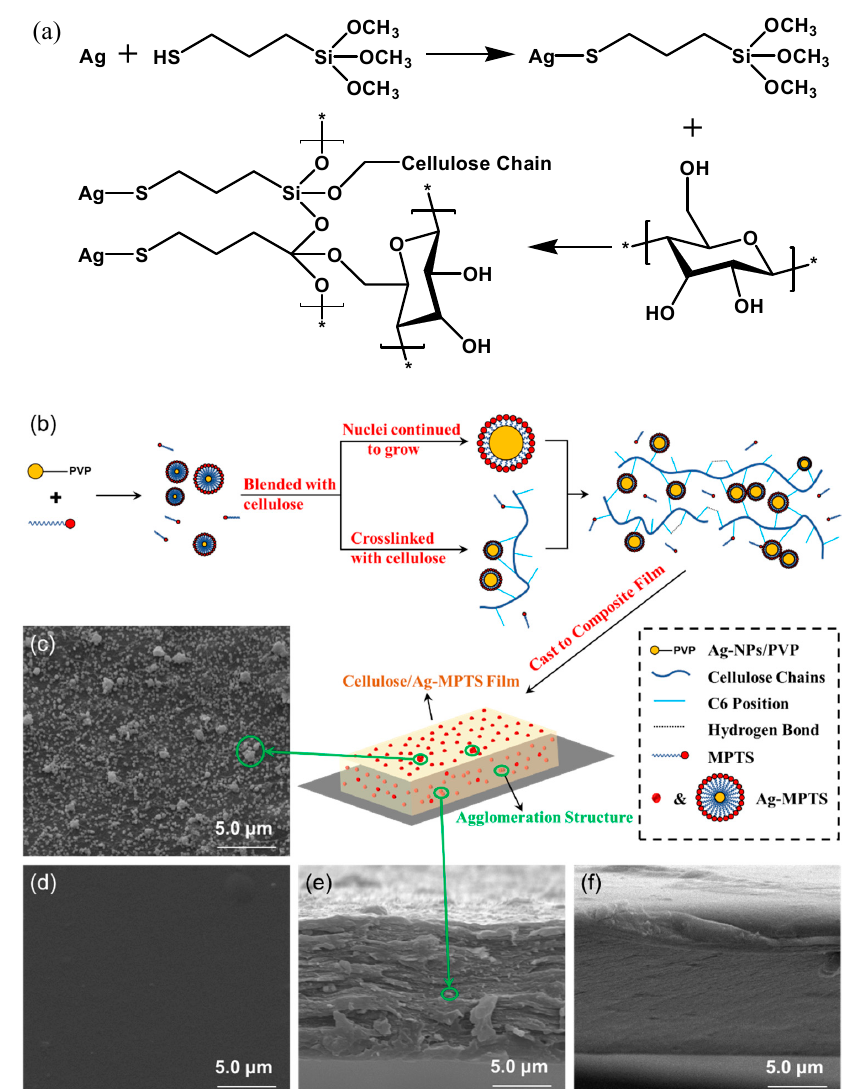
Figure 4. Reaction process and surface morphology of films: ( a ) Reaction scheme of Ag-MPTS-Cellulose cross-linked structure; ( b ) Reaction process of films; ( c , e ) SEM graphs of RCF and CANF 0.04 surface; ( d , f ) SEM graphs of RCF and CANF 0.04